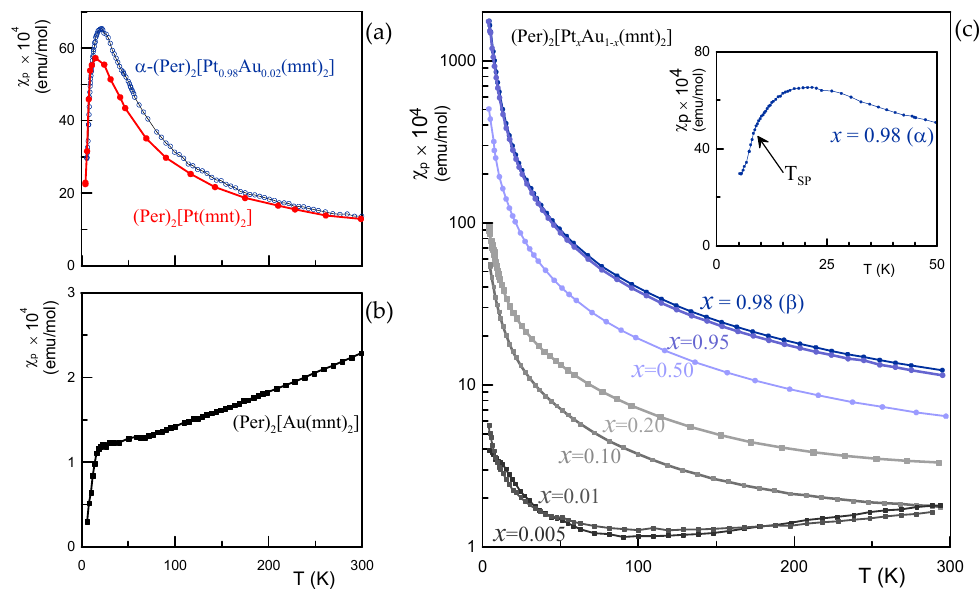
Figure 5. Paramagnetic susceptibility, χ P , of (Per) 2 [Pt x Au (1 − x ) (mnt) 2 ] with composition x indicated, as a function of temperature, T . ( a ) Pt compound and x = 0.98, α -phase; ( b ) Au compound; ( c ) 0.005 ≤ x ≤ 0.95 and 0.98, β -phase. The inset shows the behavior of a α -phase sample with x = 0.98. The paramagnetic susceptibility of (Per) 2 [Pt x -Au (1 − x ) (mnt) 2 ] could result from donor and acceptor contributions. For the α -phase, the donor contribution, due to the delocalized conduction electrons in the perylene stacks, was expected to be identical to that of the pure Au compound. The remaining contribution of the paramagnetic [Pt(mnt) 2 ] anions could therefore be deduced from the total paramagnetic susceptibility after subtraction of the small Pauli-like contribution of the pure Au compound. This last contribution in samples with x up to 0.95 and 0.98 of β -phase was found to follow above 50 K a Curie–Weiss law with small Weiss constants (<5 K) and Curie constant C close to that that expected for S = 1/2 spins with g ≈ 2.0 (C = 0.375 emu K/mole), with no difference between α and β phases, as shown in Figure 6. A significant deviation was however observed for x = 0.98 of α -phase, which approached the behavior of the pure Pt